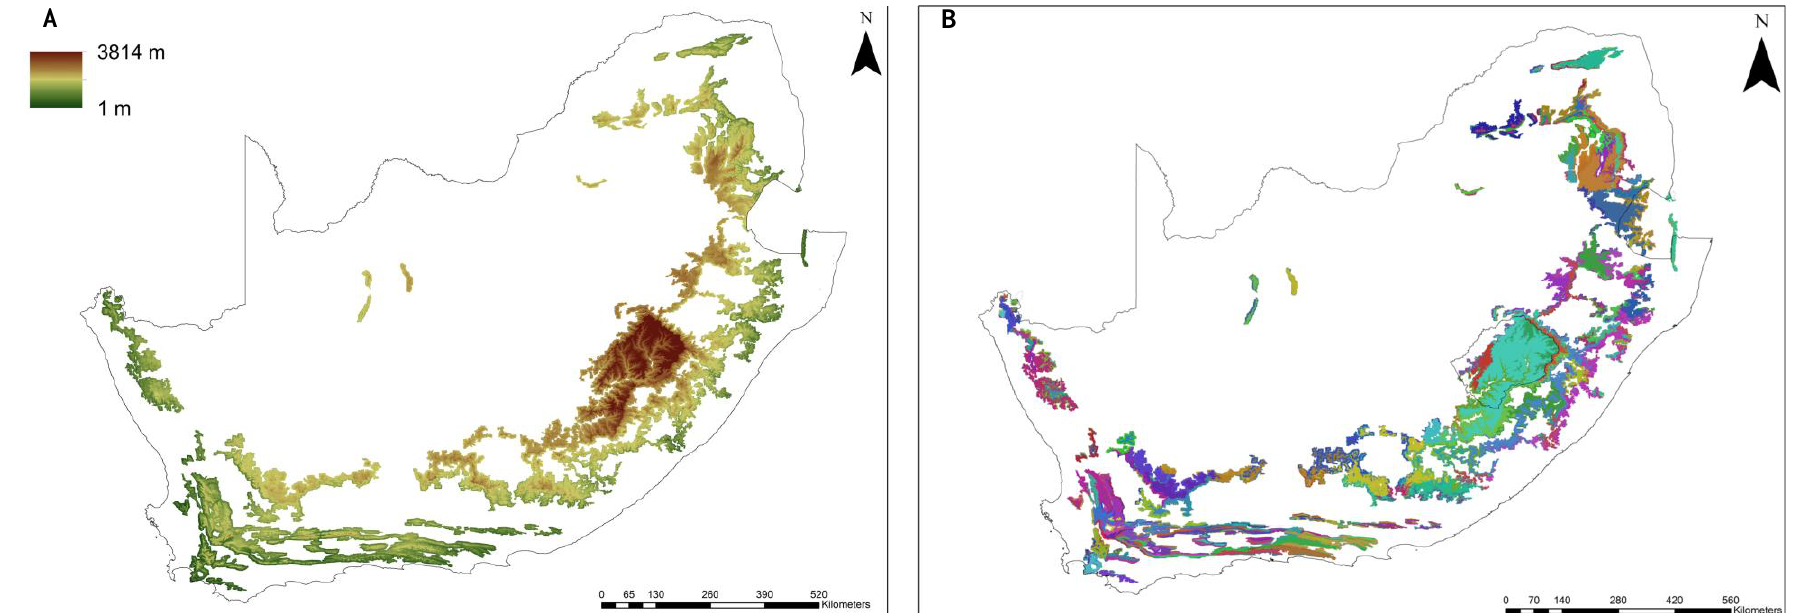
Figure 3. A. The elevational gradient (metres) across the mountains of South Africa. B. The vegetation types within South African mountains: EGE — 438; TC — 30; CGM — Figure 3. ( A ). The elevational gradient (metres) across the mountains of South Africa. ( B ). The vegetation types within South African mountains: EGE—438; TC—30; CGM—7; SGE—17; WGE—36, CFM—139 vegetation types according to Rutherford et al. [32] (see Table S2 and Figure S1 for vegetation type